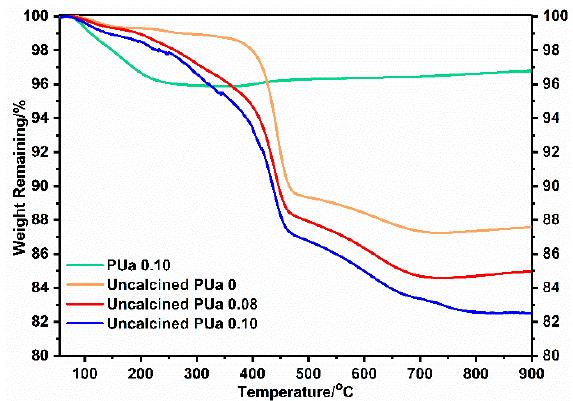
Figure 3. TG profiles of the as-synthesized SAPO-34 samples with and without PUa as mesoporogen.